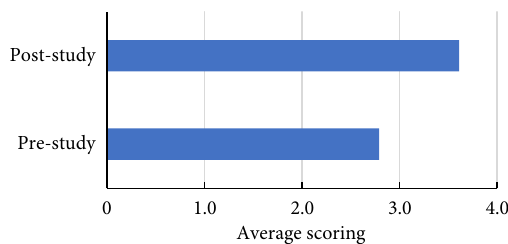
Fig. 7 Participants ’ average scoring for the pre- and post-studies for Hypothesis 1.